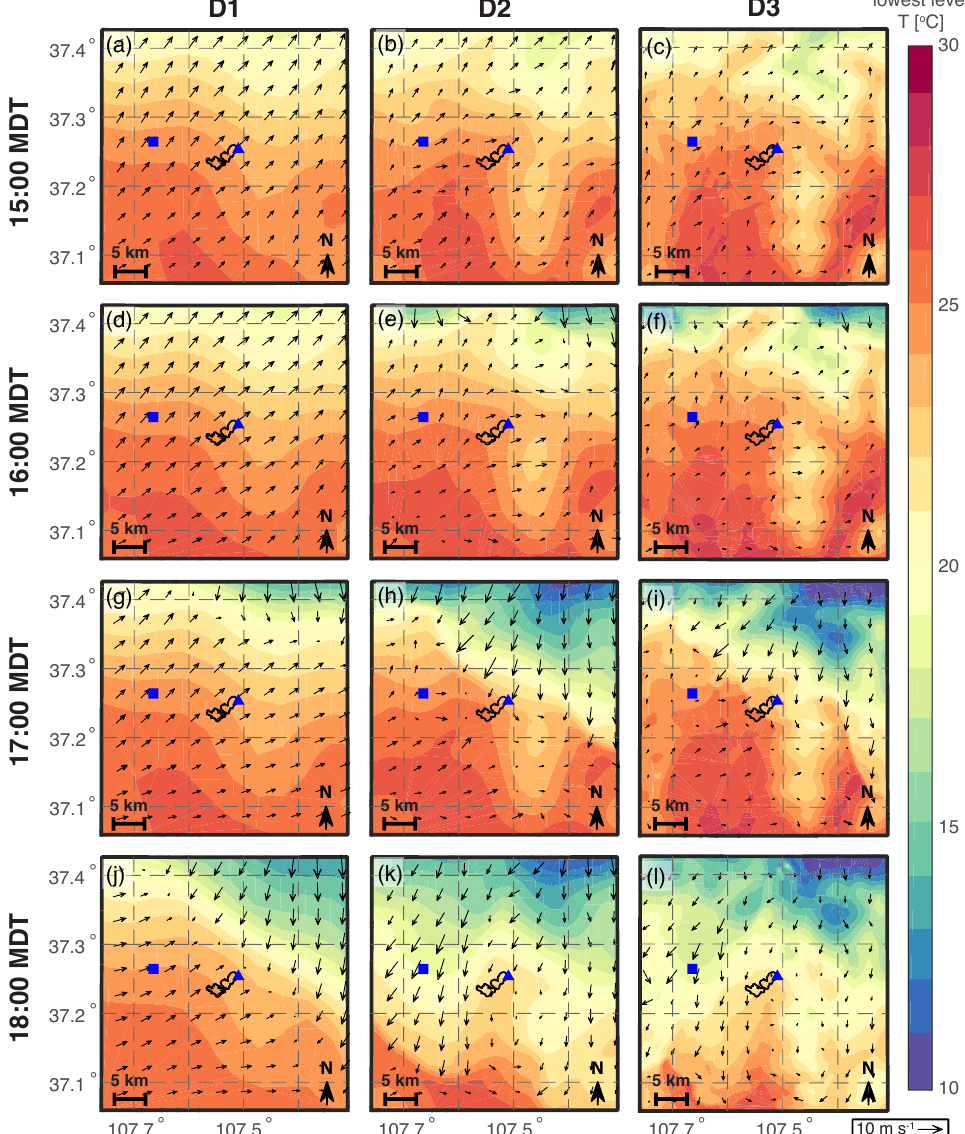
Figure 6. Contoured maps of lowest model level temperature and horizontal wind vectors between ( a – c ) 15:00 and ( j – l ) 18:00 MDT 10 September 2018, with a 1-h interval between rows, in domains (left) D1, (center) D2, and (right) D3; the same region (domain D3) is depicted for all three domains. Contour interval is 1 °C, and vector reference scale is included in lower-right corner of figure. The black polygons in the center of each panel depict the perimeters of the two burn units active on 10 September 2018, and the blue square and triangle indicate the locations of the San Juan Portable RAWS (Figure 5a), and portable rawinsonde and LiDAR ceilometer (Figures 3 and 4, respectively). For reference, the lowest model level in domains D1, D2, and D3 is 25 m, 12.5 m, and 5 m AGL, respectively (Table